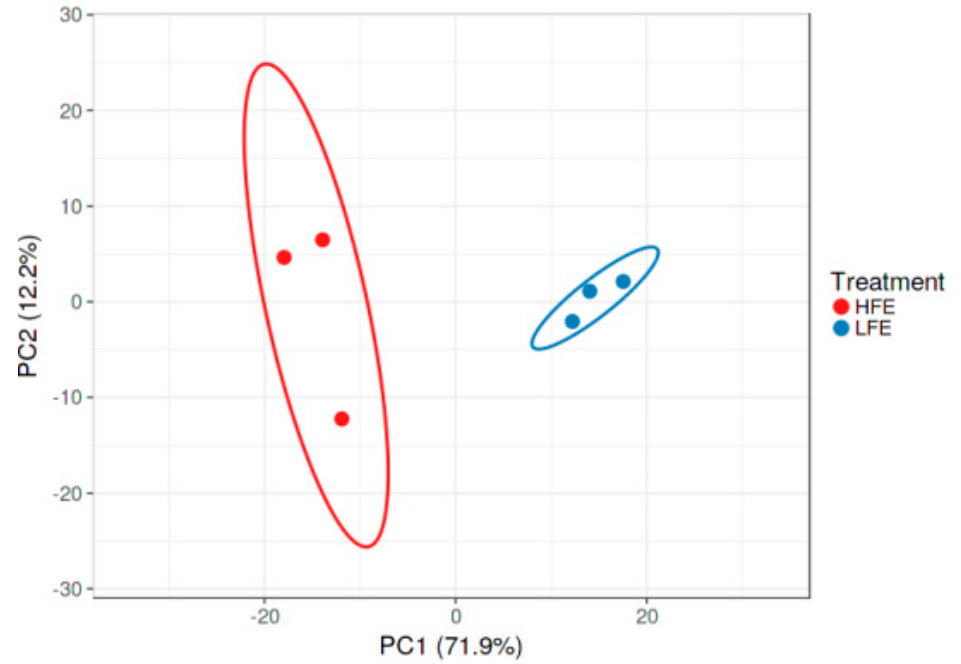
Figure 1. Classification of HFE and LFE turkeys according to the results of multiple corresponding analyses. The results show that HFE and LFE turkeys can be divided into two groups.